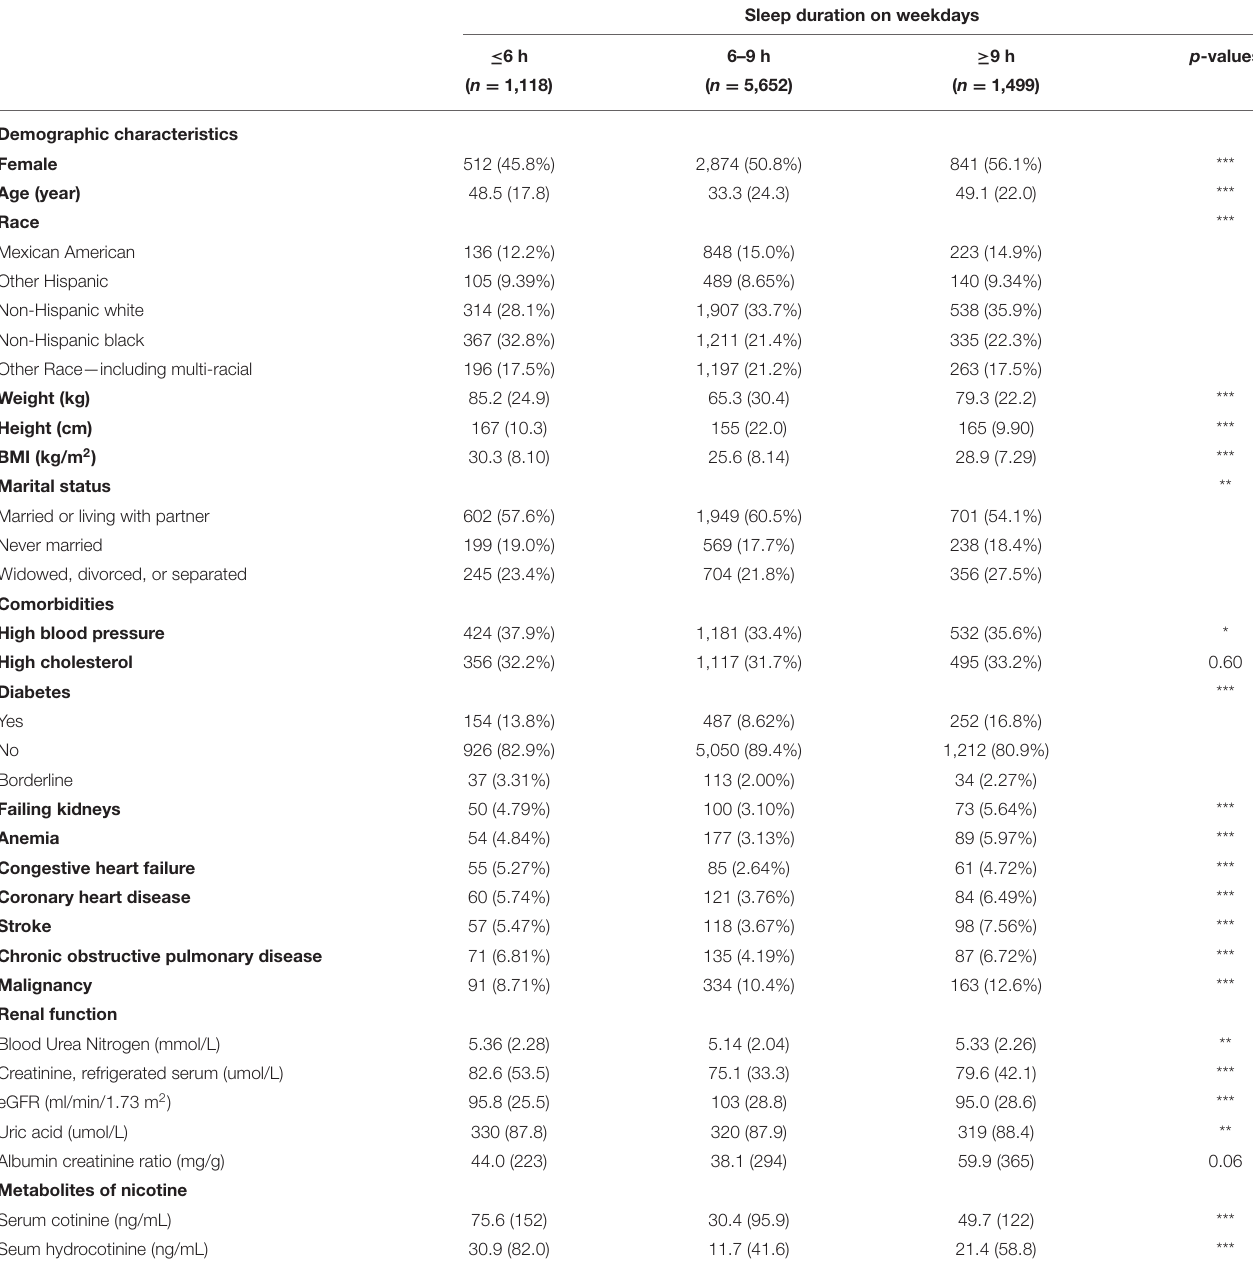
TABLE 2 | Baseline characteristics of study population grouped by sleep duration.